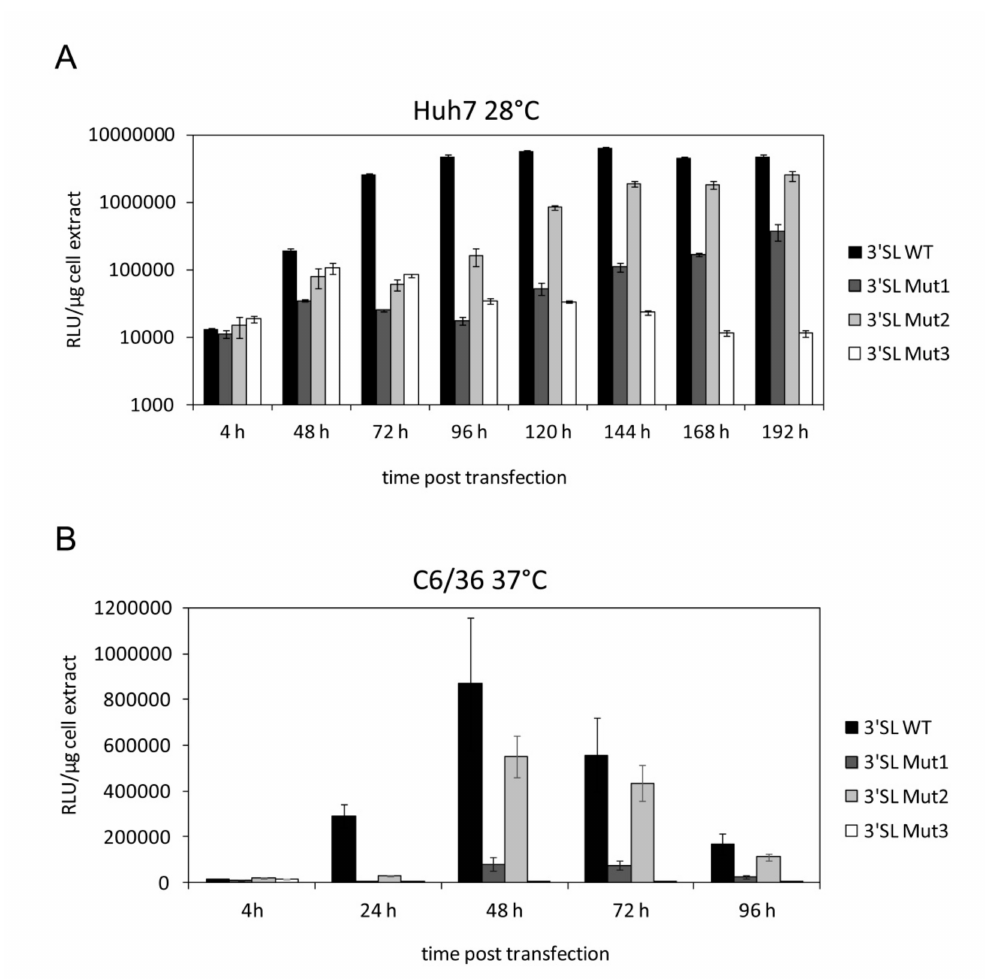
Figure 4. The cultivation temperature determines the replication rates of WNVRluc replicons. ( A ) Huh7 cells were transfected with wild-type and mutant WNVRluc replicon RNAs, subsequently cultivated at 28 ◦ C and analyzed for luciferase reporter activity at the indicated time points post transfection. Results from one representative experiment performed in triplicate are shown and error bars reflect standard deviations. ( B ) Same as in (A) except that C6 / 36 cells were used and cultivated at 37 ◦ C after